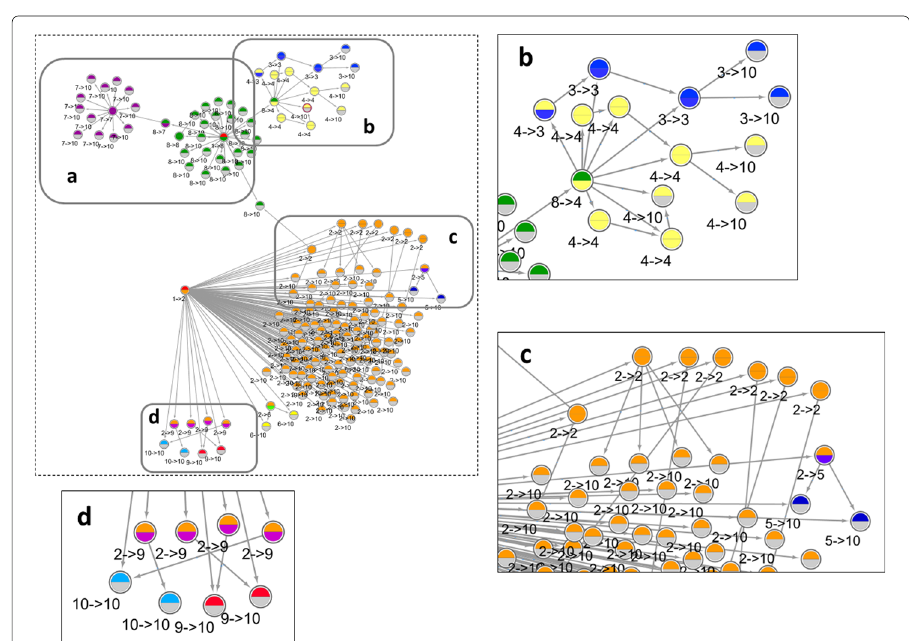
Fig. 5 Relational patterns in the Bob Dylan information diffusion